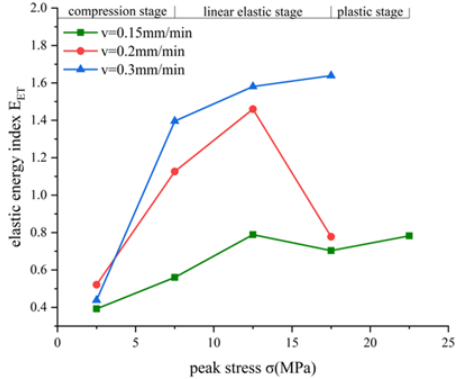
Figure 11. Change process of elastic energy index at different loading rates.